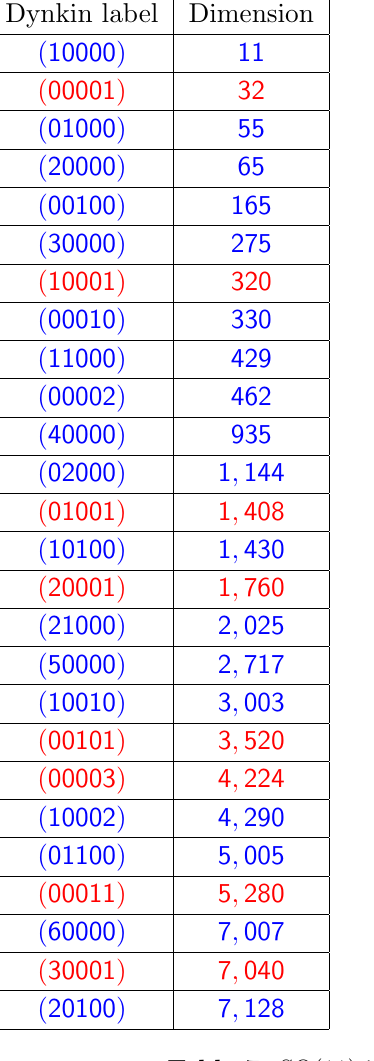
Table 7. SO(11) irreducible representations